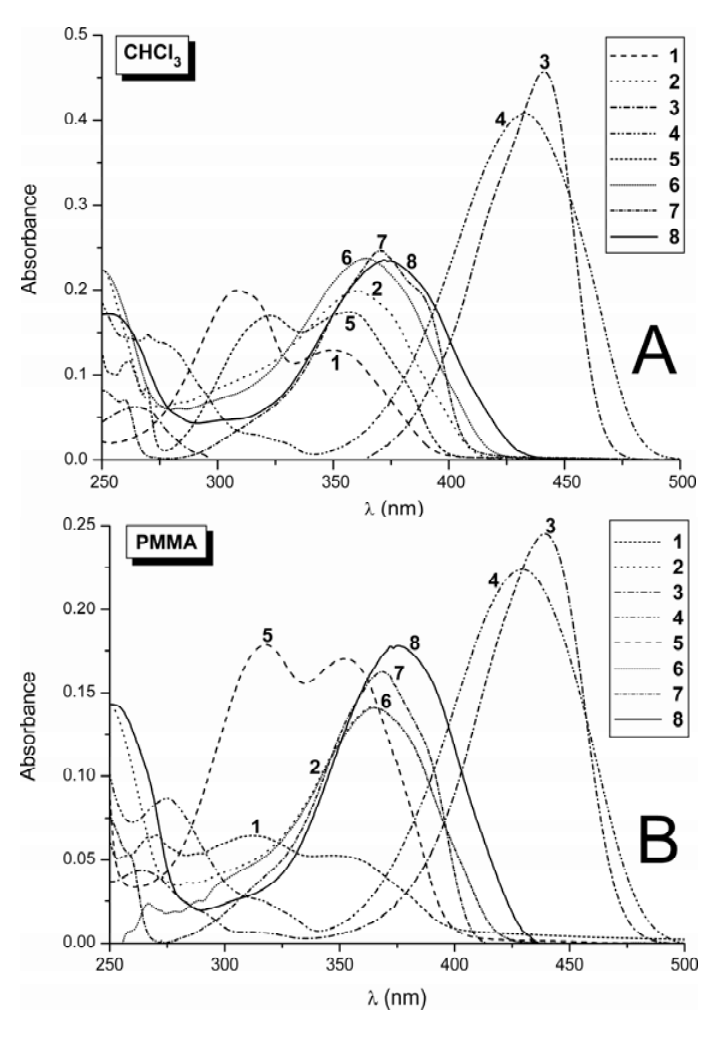
Figure 2. ( A ) Absorption spectra of coumarins 1 – 8 in chloroform at 10 − 5 mol·dm − 3 . ( B ) Absorption spectra of coumarins 1 – 8 in PMMA at 0.002 mol·kg − 1